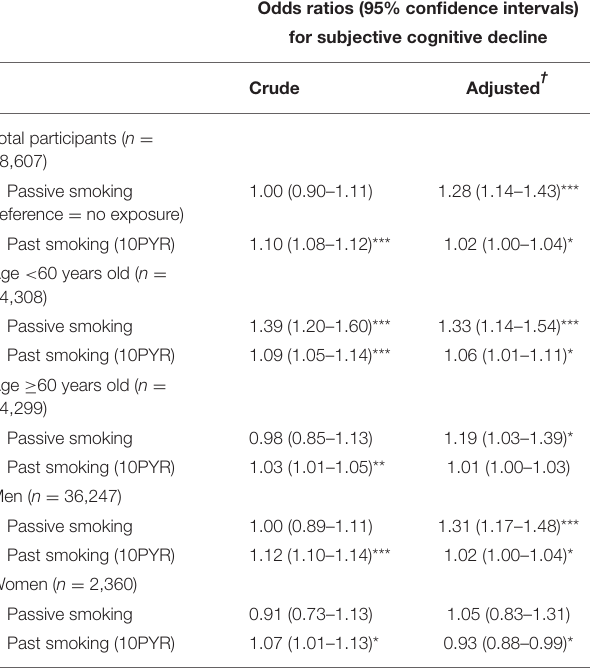
TABLE 4 | Crude and adjusted odds ratios and 95% confidence intervals for TABLE 3 | Crude and adjusted odds ratios and 95% confidence intervals of subjective cognitive decline according to passive smoking and lifetime pack years passive smoking for subjective cognitive decline among non-smokers. among past Odds ratios (95% confidence intervals)